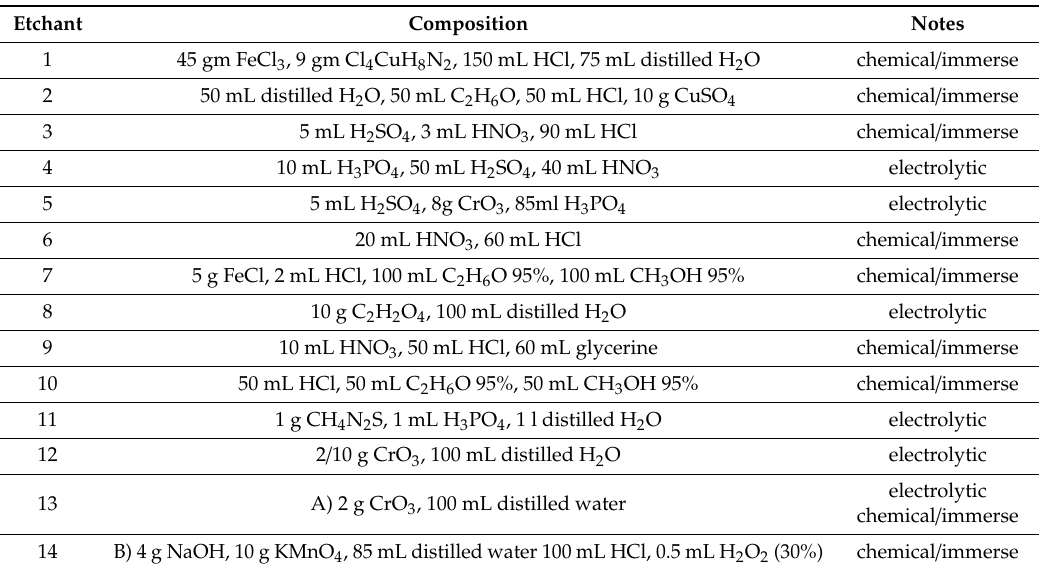
Table 2. Etchants applied for the Ni-based